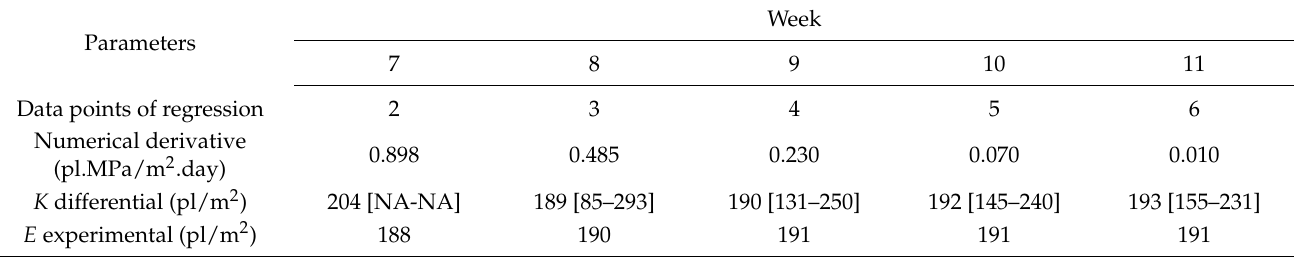
Table 2. Parameters of the graphical outputs of Figure 1 for the dataset Papaver rhoeas –Igualada-2008. Number of points involved in the linear regression, numerical derivative of the emergence with standard error, expected maximum weed seedling population according to the differential approach ( K differential) and observed weed seedling population in the field ( E experimental) when: ( A ) the emergence and the numerical derivative of the emergence were smoothed and ( B ) only the numerical derivative of the emergence was